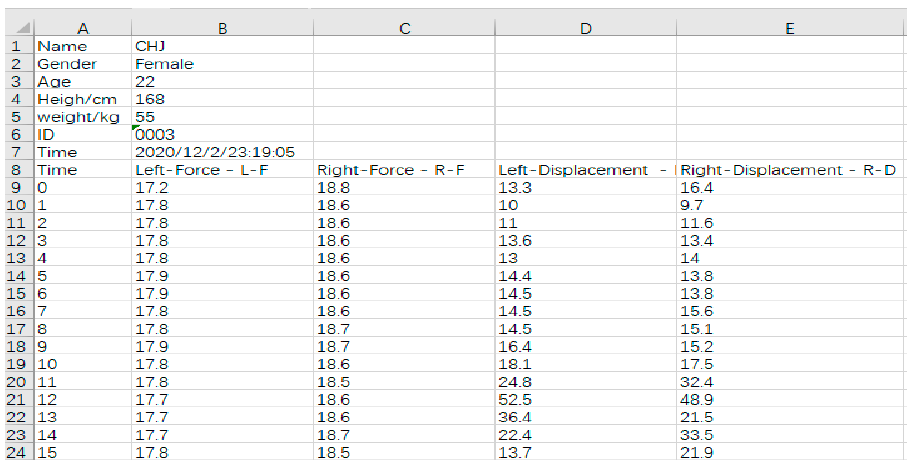
Figure 16. File export diagram of patient data.